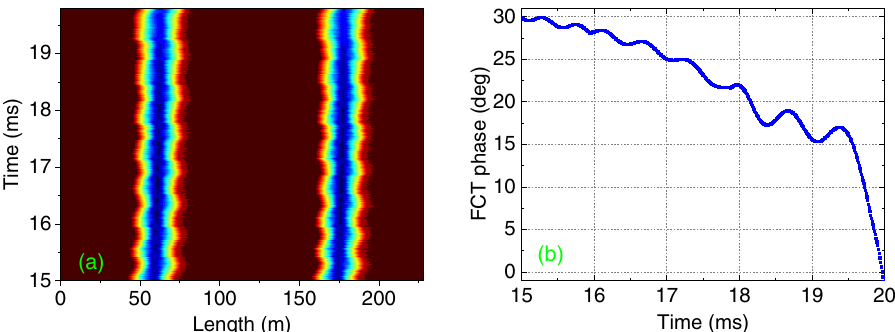
FIG. 3. (a) Charge distribution of the two bunches in the CSNS/RCS measured by the WCM from 15 to 19.8 ms. (b) Oscillation of the bunch center measured by the FCT in the same period.